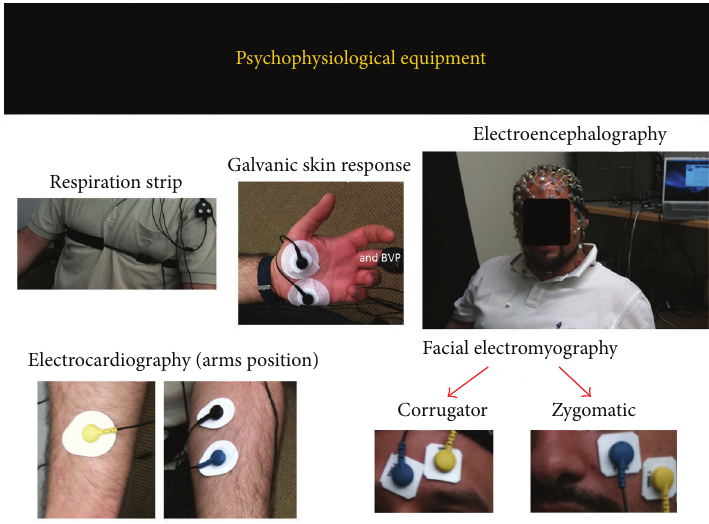
Figure 3: Psychophysiological